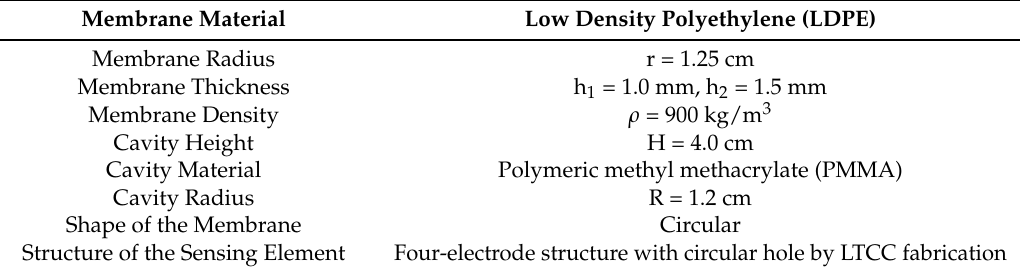
Table 2. Experimental parameters.